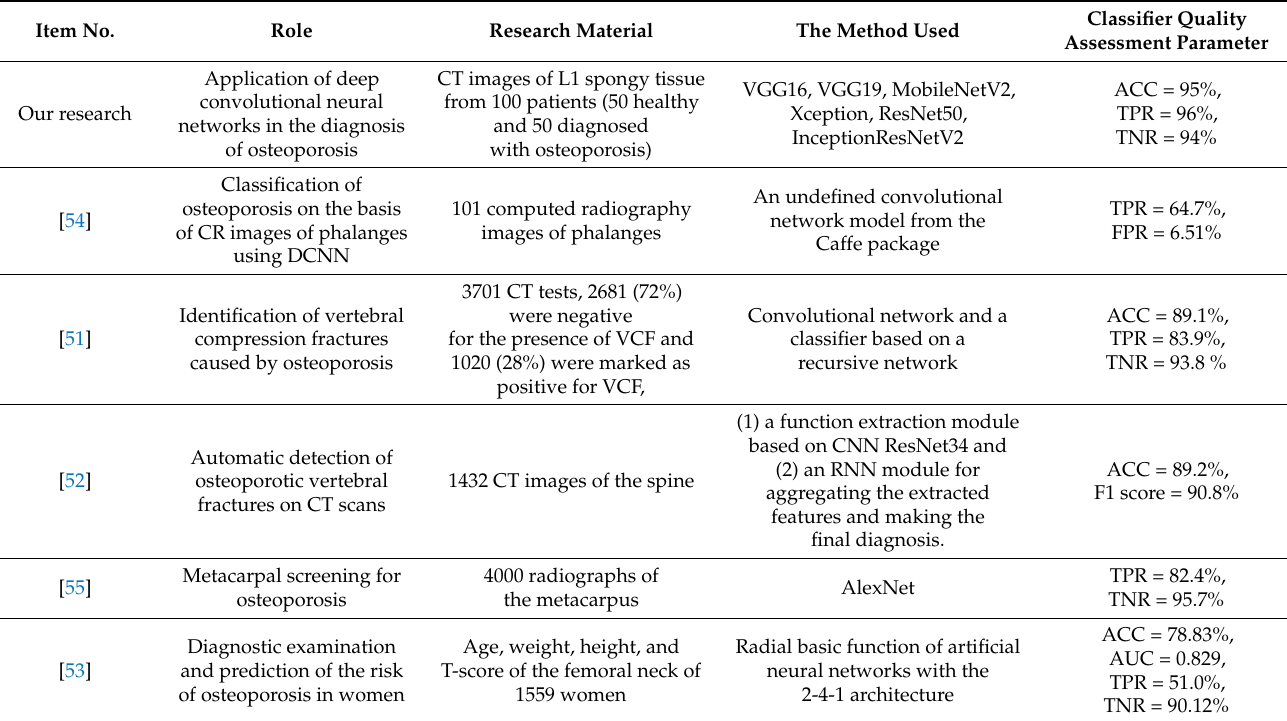
Table 4. Comparison with other